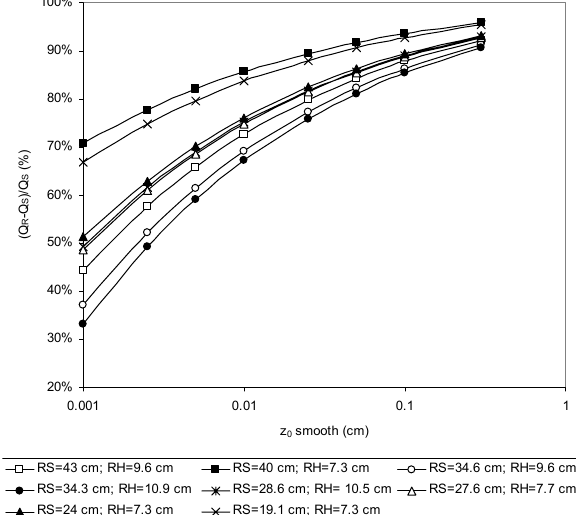
FIGURE 12 Fig. 12. Sensitivity of the erosion flux reduction over ridged sur- faces to the roughness length of the corresponding smooth surface, for a wind velocity=14m.s − 1